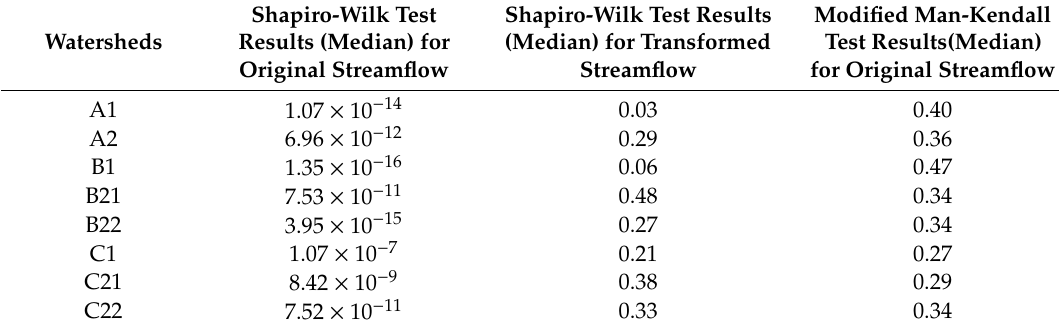
Table 1. Normality and trend analysis test results for the streamflow data for eight watershed